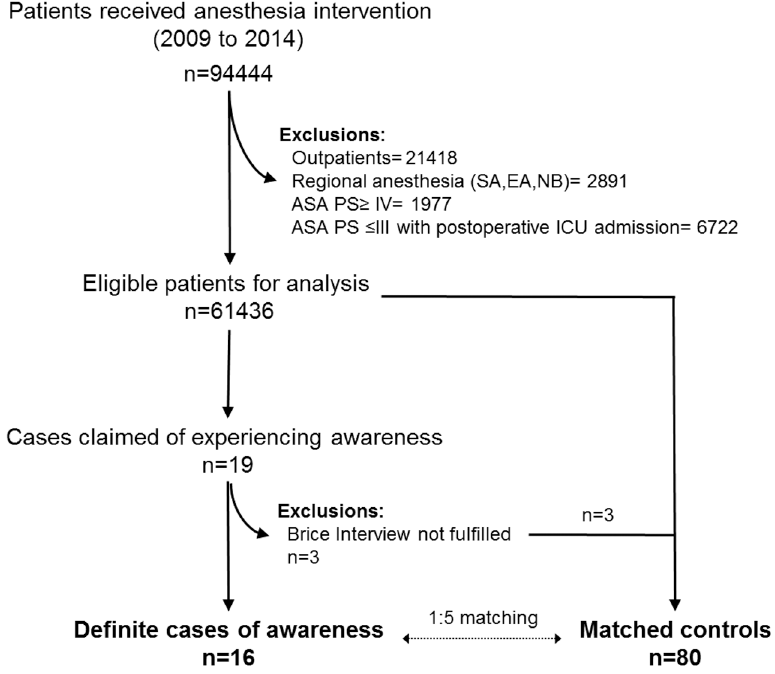
Fig 1. Study design and flow diagram. ASA PS: AmericanAssociationof Anesthesiologists physicalstatus; EA: epiduralanesthesia; ICU: intensivecare unit; NB: nerve block; SA: spinal anesthesia.